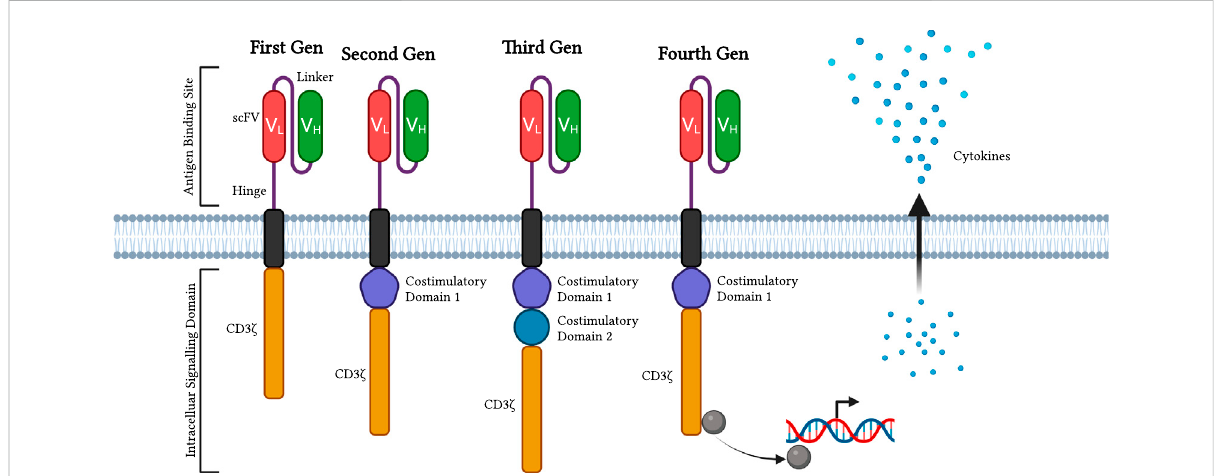
FIGURE 3 Visualization of CAR-T and CAR-M immunotherapy strategies. This diagram demonstrates strategies for enhancing CAR-T and CAR-M immunotherapiestotreatcancers.CD19ortumour-speci fi cantigentargetingCAR-TcanbeimprovedbyusingPD-1orCTLA-4blockingstrategies. Speci fi cally, CTLA-4 helps with immature T cell priming after CAR-T injection, which helps improve overall CAR-T ef fi ciency. PD-1/PD-L1 blocking unleashes activated T cell abilities, reduces T cell exhaustion and aids TME toxicity effects. On the other hand, CD19/HER2 dual CAR-M